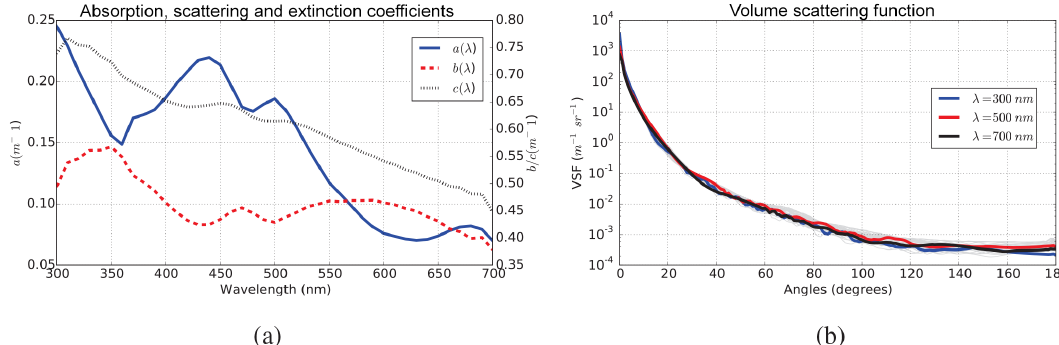
Figure 5. (a) Absorption ( a(λ) ), scattering ( b(λ) ), and extinction ( c(λ) ) coefficients and (b) the volume scattering function for spherical- shaped homogeneous particles (three wavelengths: 300, 500, and 700nm, are plotted using intense colors, whereas the other wavelengths between 300 and 700nm are plotted in light